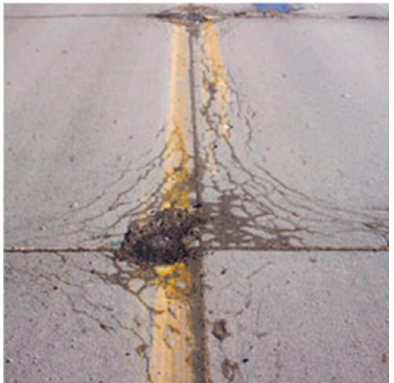
Figure 1. Demonstration of D-cracking in concrete pavement [11].